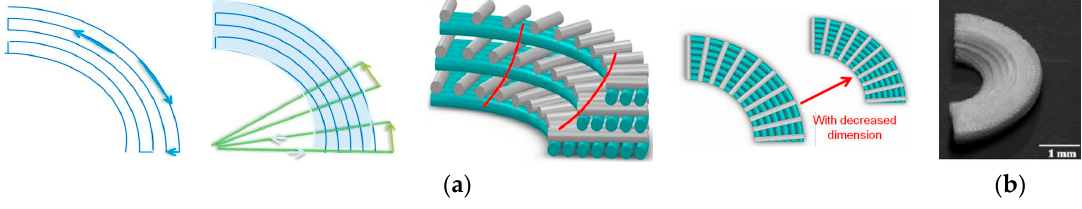
Figure 3. ( a ) Fabrication pathway; ( b ) 3D wedge-shaped meniscal scaffold (adapted from [68]).